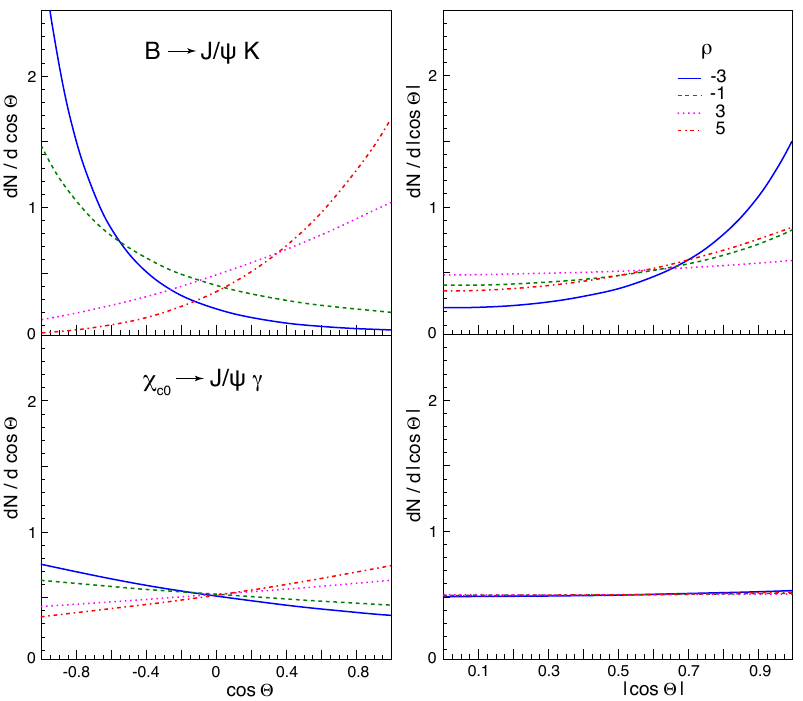
Figure 3 . Examples of cos Θ (left) and | cos Θ | (right) distributions for the decays B → J /ψ K (top) and χ c 0 → J /ψ γ (bottom), when the experiment selects samples of J /ψ mesons having p distributions ∝ ( p/m ) − ρ , for several values of ρ